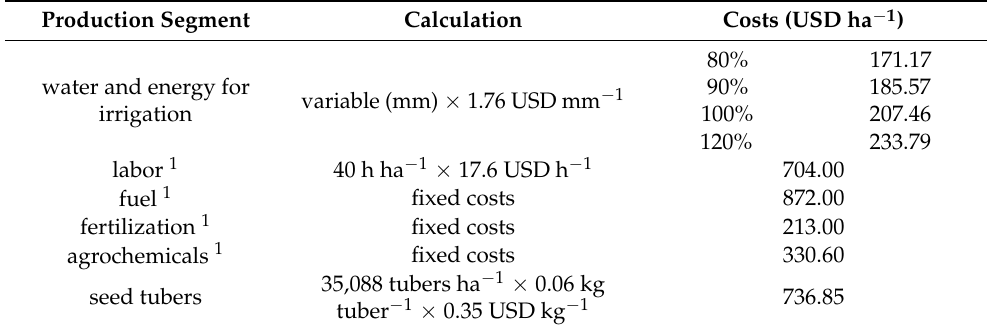
Table 2. Variable and fixed production costs in potato production during the field experiment 2021